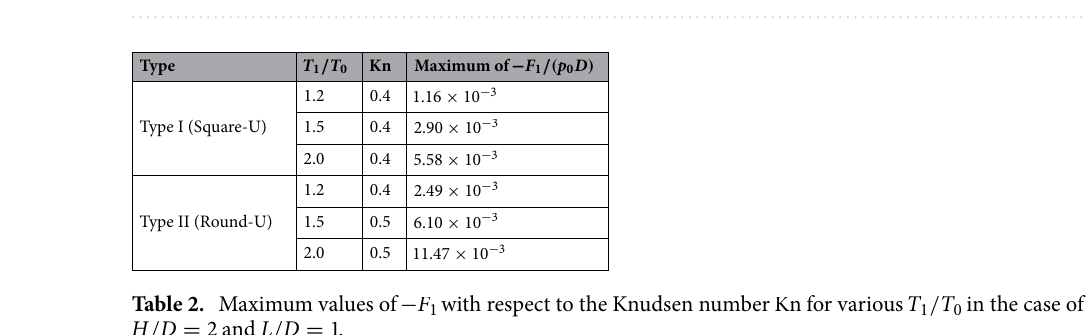
2 and L / D 1 ( T 1 / T 0 1.2 , 1.5, and 2). = = =